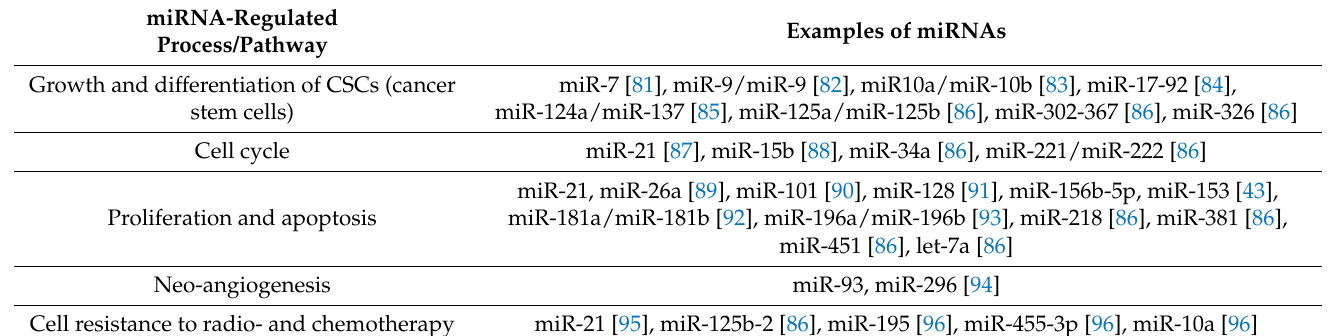
Table 2. The role of selected miRNAs in GBM.